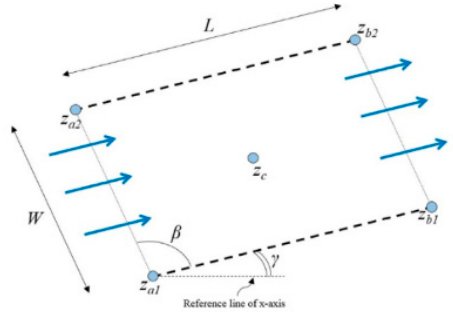
Figure 1. Natural fracture model. L and W are the length and width; z c is the center; z a 1 , z a 2 , z b 1 , and z b 2 are the corners; β is the wall angles, while γ is the rotation angle of the natural fracture. Intended flow direction indicated with blue arrows. Reproduced with permission from [4].